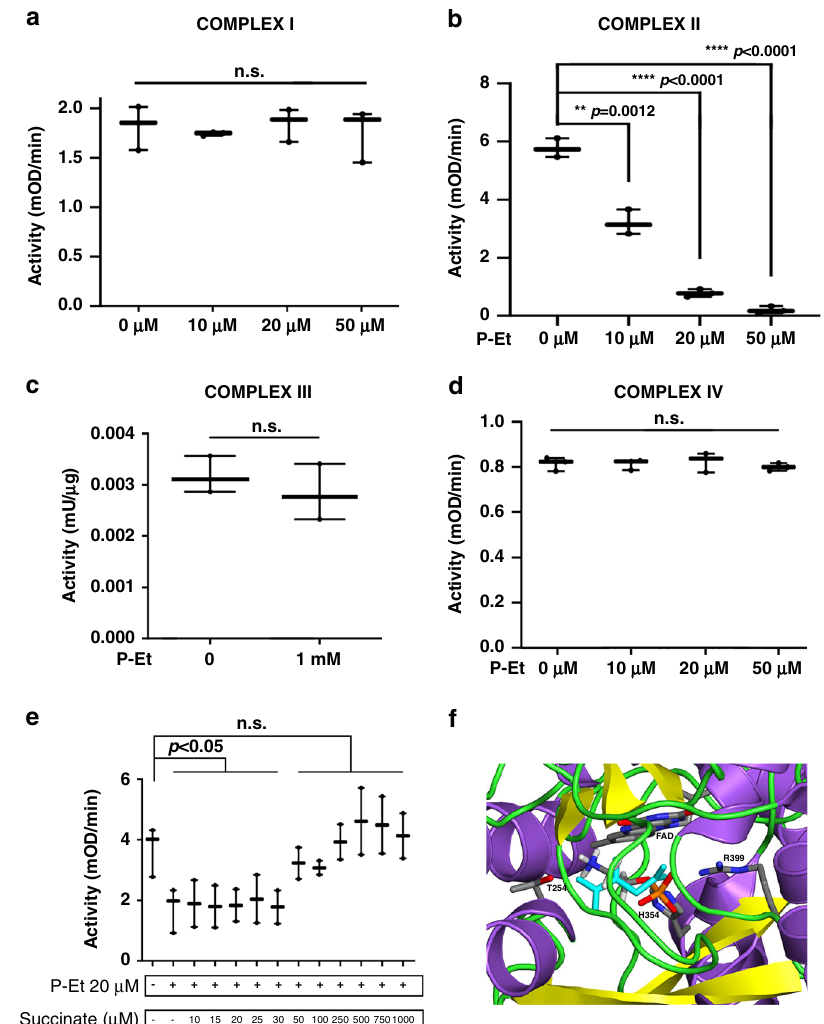
Fig. 6 Activity of mitochondria complexes I – IV. a – d Activity of ETNK1-WT mitochondria complexes I – IV in the presence of increasing concentrations of P- Et. The analysis of complexes I ( n = 3 independent replicates), II ( n = 3 independent replicates), and IV ( n = 3 independent replicates) was performed on mitochondria lysates, while the analysis of complex III ( n = 3 independent replicates) was performed on intact isolated mitochondria. The boxplots delimit the interquartile range; the central bar represents the median; the whiskers extend from minimum to maximum. Statistical analyses were performed using one-way ANOVA with Tukey ’ s post-hoc test a , b , d and two-sided t -test c . e The activity of the mitochondria complex II was assessed in the absence and presence of 20 µ M P-Et in combination with increasing concentrations of succinate. The boxplots delimit the interquartile range; the central bar represents the median; the whiskers extend from minimum to maximum ( n = 3 independent replicates). Statistical analyses were performed using one-way ANOVA with Tukey ’ s post-hoc test. f One of the best docking poses of P-Et onto the crystal structure of SDH (PDB: 1NEN) is shown. P-Et is represented in sticks colored by atom type. The protein is represented in cartoons colored according to secondary structure, i.e. helices, strands, and loops are, respectively, violet, yellow, and green. FAD and selected amino acid side chains in the catalytic site are represented in sticks colored by atom type. Succinate from the 1NEN complex is also shown in cyan sticks. Hydrogen atoms are shown only on P-Et. Source data are provided as a Source data fi